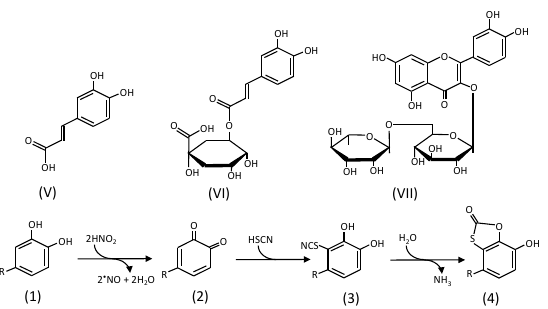
Figure 2. Postulated mechanism of the formation of oxathiolone derivatives from phenolic compounds [33,53]. ( V ) caffeic acid, ( VI ) chlorogenic acid, ( VII ) rutin. (1) phenolic compound with a catechol group, (2) quinone of the phenolic compound, (3) thiocyanate conjugate, (4) oxathiolone